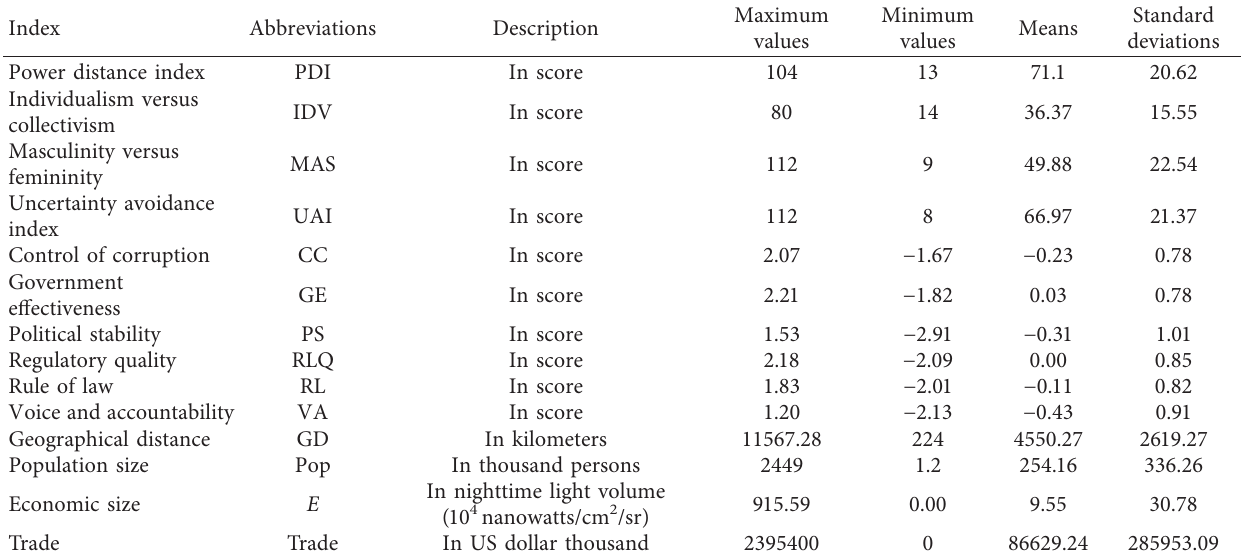
Table 1: Description of variables.